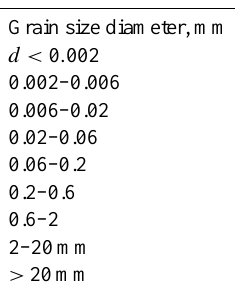
Table 4. Intervals used in the grain size